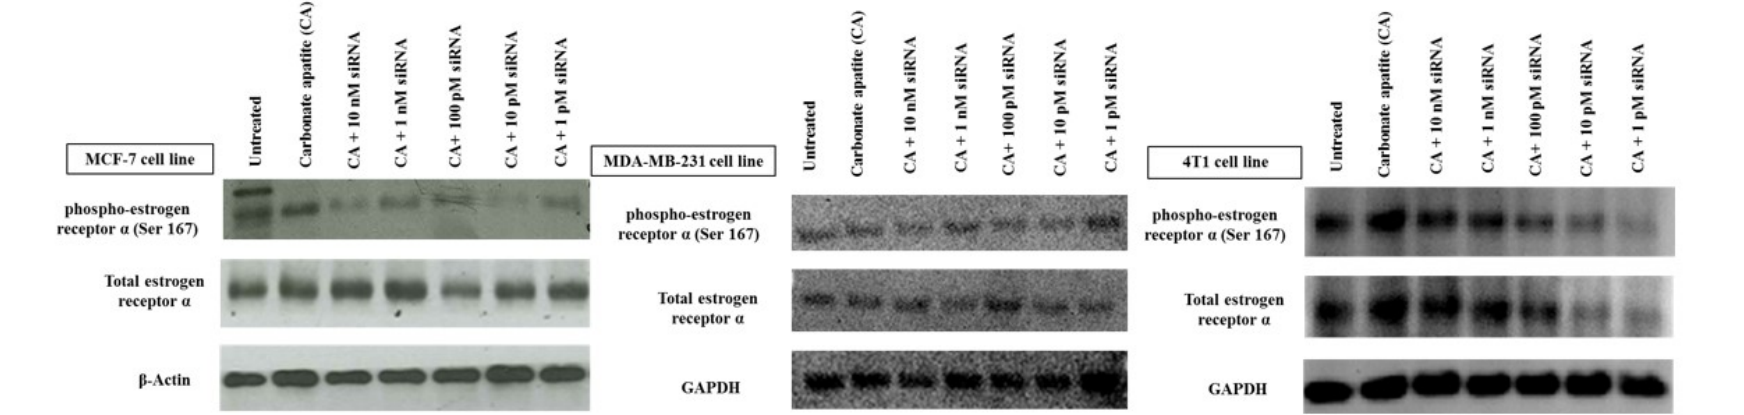
Figure 2. Effects of intracellular delivery of CA-ESR1 siRNA complexes on expression and activation of estrogen receptor α in MCF-7, MDA-MB-231 and 4T1 cell lines. Cells were incubated with CA-ESR1 complexes for 48 h prior to cell lysis for protein extraction and Western blot analysis. Proteins were loaded on SDA-PAGE and transferred onto nitrocellulose membrane for detection of phosphorylated estrogen receptor (ER) α , total ER α and GAPDH (housekeeping protein) expression.